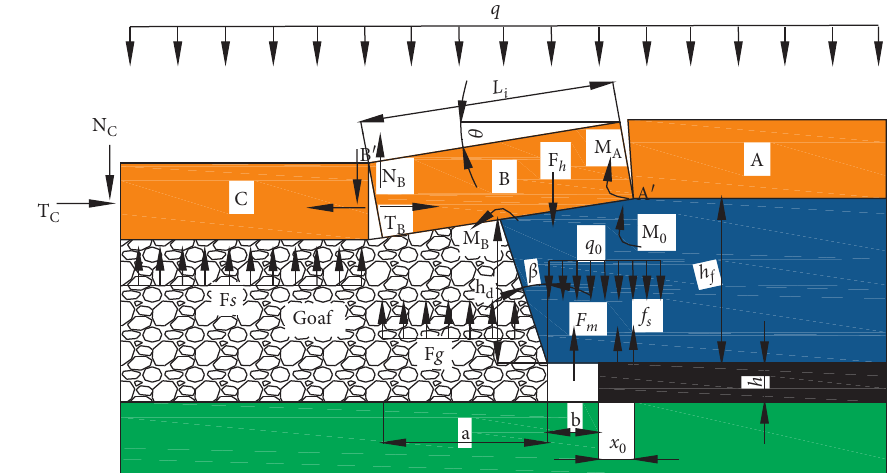
Figure 11: Mechanical model of the hinged rock